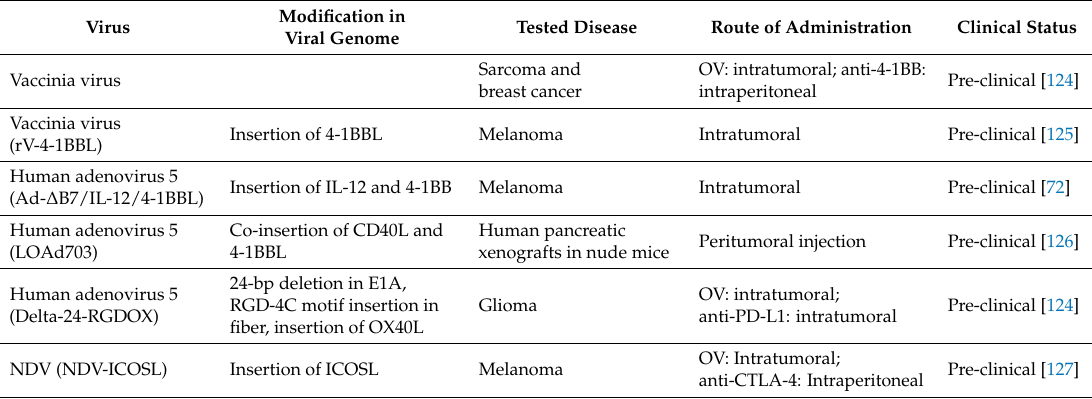
Table 3. Combinational therapies including immune co-stimulatory agents and OVs. Modification in Virus Viral